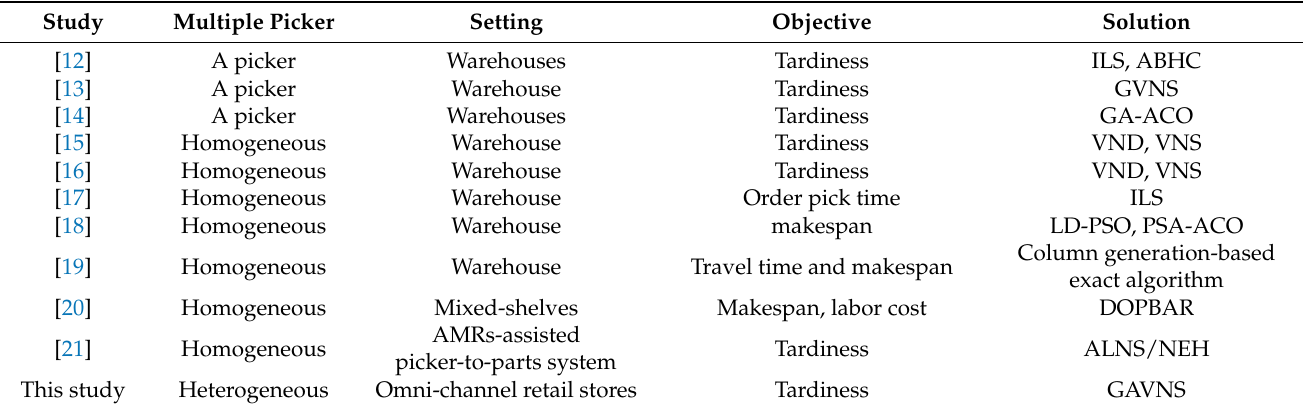
Table 1. Summary of related